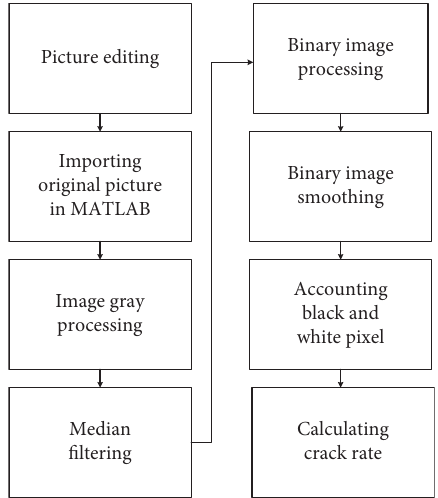
Figure 2: Flowchart for digital image